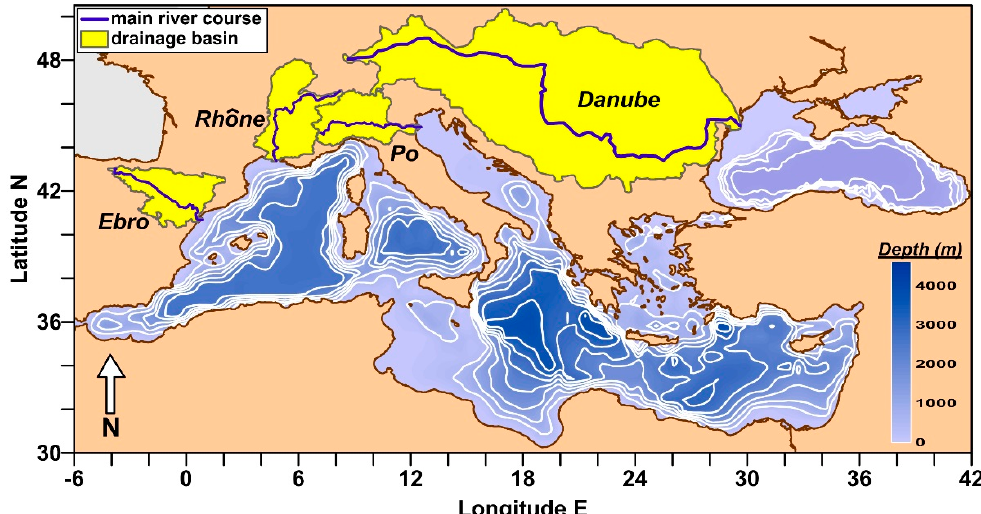
Figure 1. Drainage basins and main river courses of the Ebro, Rhône, Po and Danube.